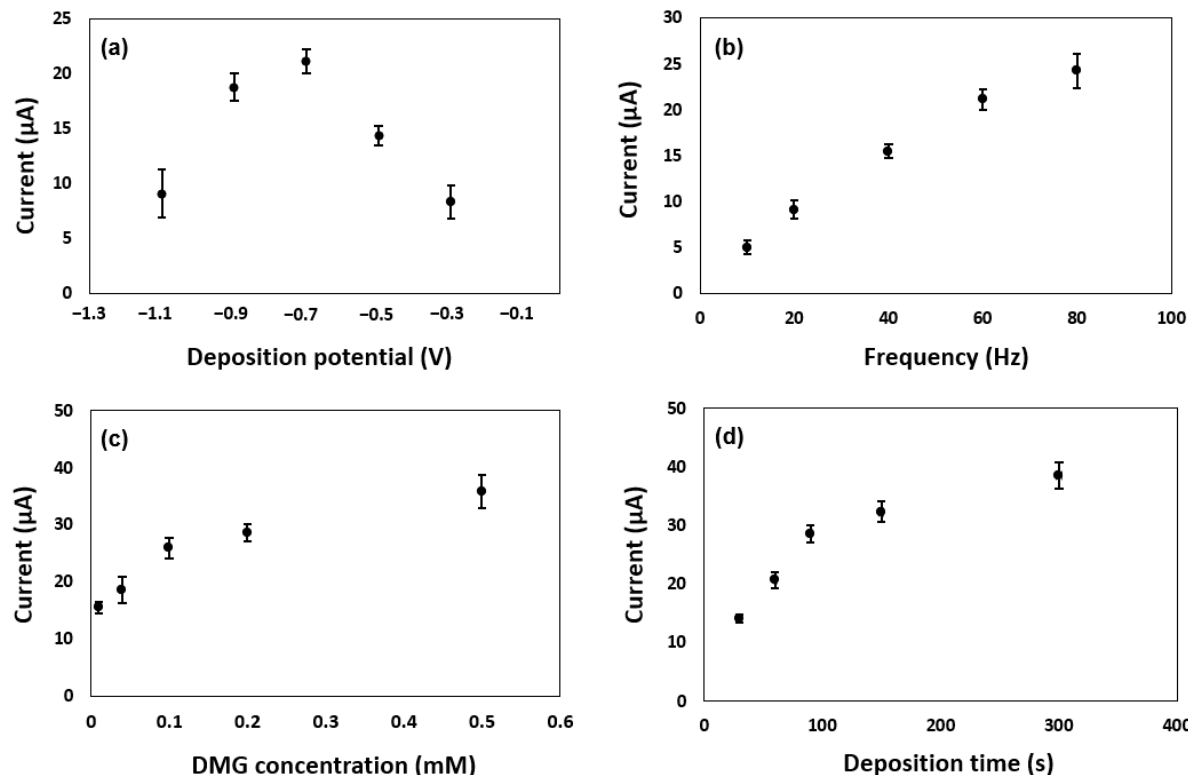
Figure 2. Optimization of SWAdCSV operating parameters for Co(II) detection: ( a ) deposition potential, ( b ) frequency, ( c ) DMG concentration, and ( d ) deposition time. SWAdCSV was performed in 0.1 M ammonia buffer solution at pH 9.2 containing 50 µ g L − 1 of Co(II).